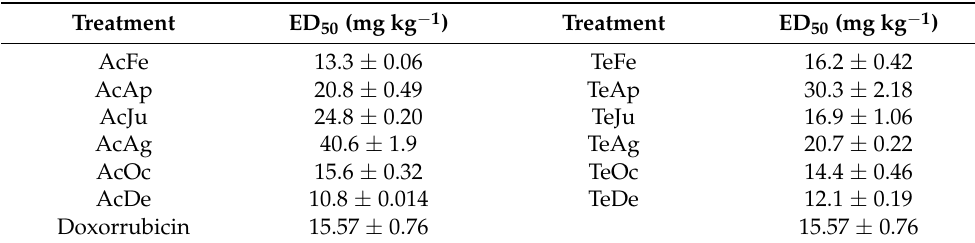
Table 3. Results of antitumor activity of the ethanol extracts from A. muricata leaves in a breast cancer model with 4T1 cells.